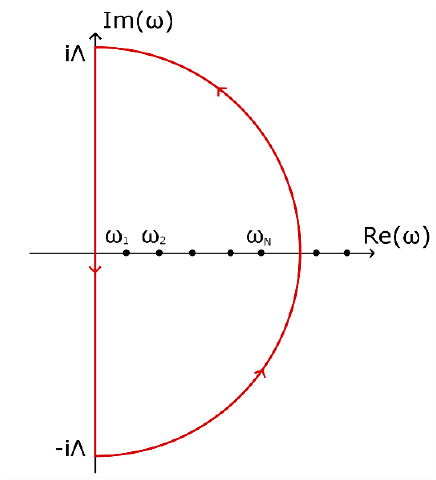
Figure 2 . The eigenfrequencies ! n are the zeroes of an analytic function f ( ! ) and are all on the real axis. To perform the sum P 1 ! n we use formula (4.70) with an appropriate choice of f ( ! ), n =1 and integrate on the contour drawn. We insert a cuto(cid:11) (cid:3) which will be later be sent to in(cid:12)nity in order to calculate the in(cid:12)nite sum over all ! n